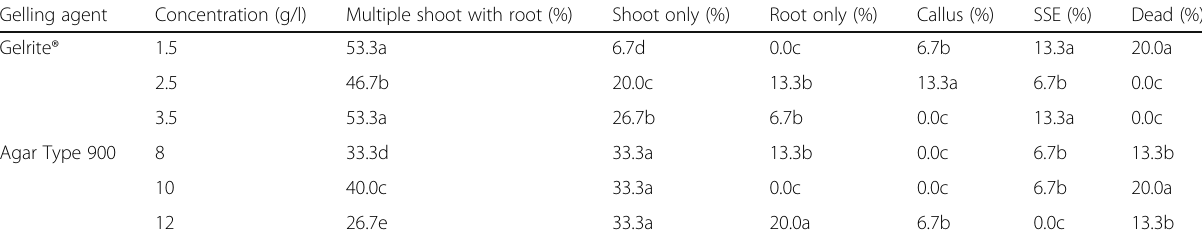
Table 3 Effect of different type of gelling agent on oil palm polyembryoids morphology after 90 days of culture Gelling agent